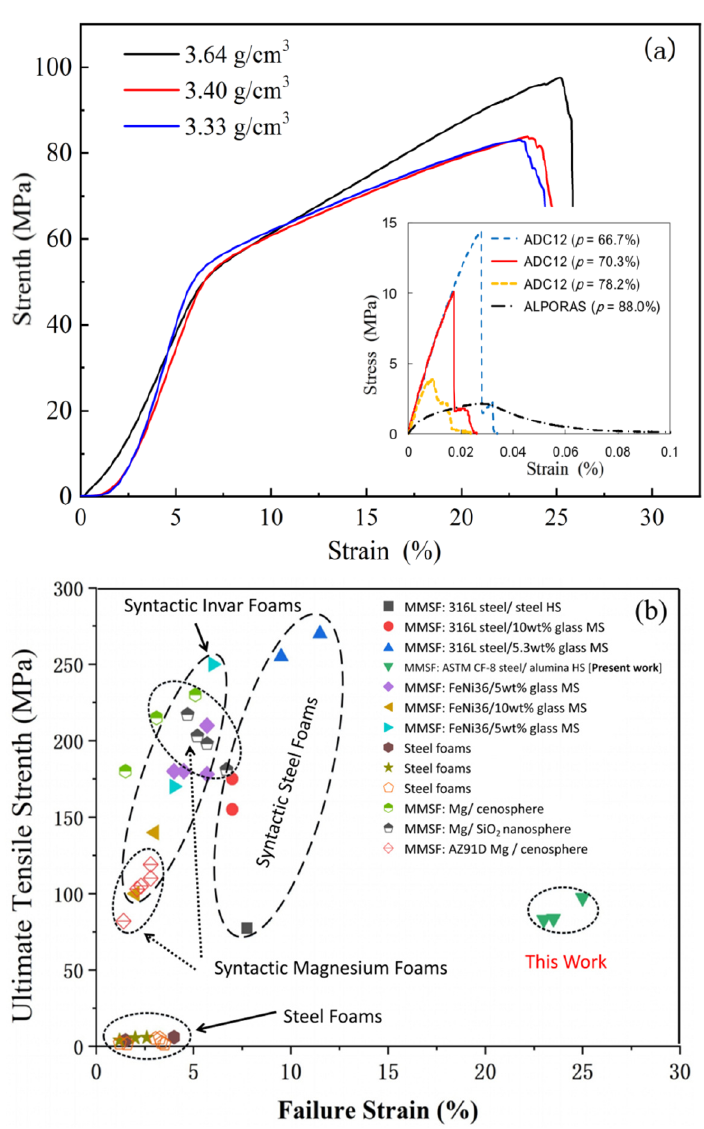
Figure 4. ( a ) Tensile stress–strain curve of SSFs and typical aluminum foam (the inner image [41]). ( b ) Comparison of the UTS of different types of metal foams [11,32,36,38,42–47].